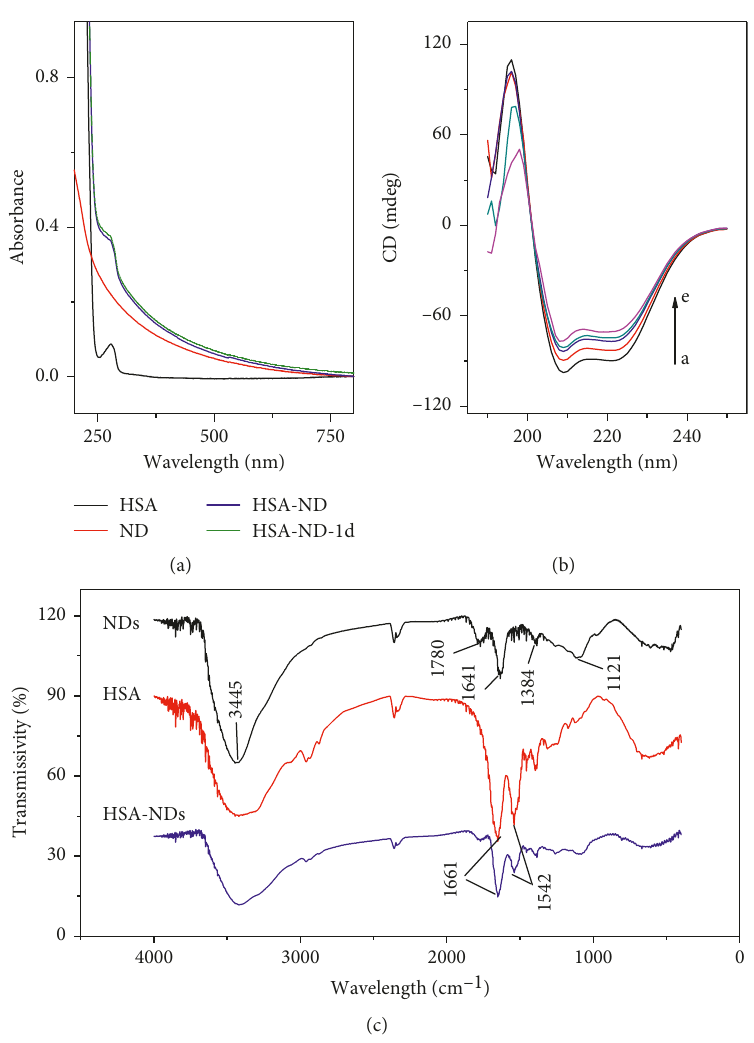
Figure 2: (a) UV-vis spectra of HSA, NDs, and HSA-NDs (green curve: HSA-NDs system was stored for one day). (b) CD spectra of 1.0 μ M HSA in 0.01 M PBS (pH 7.4) with various concentration of NDs ( c NDs from a to e: 0, 8.0, 16.0, 32.0, and 64.0mg · L − 1 , T � 298K. (c) FTIR spectra of NDs, HSA, and HSA-NDs